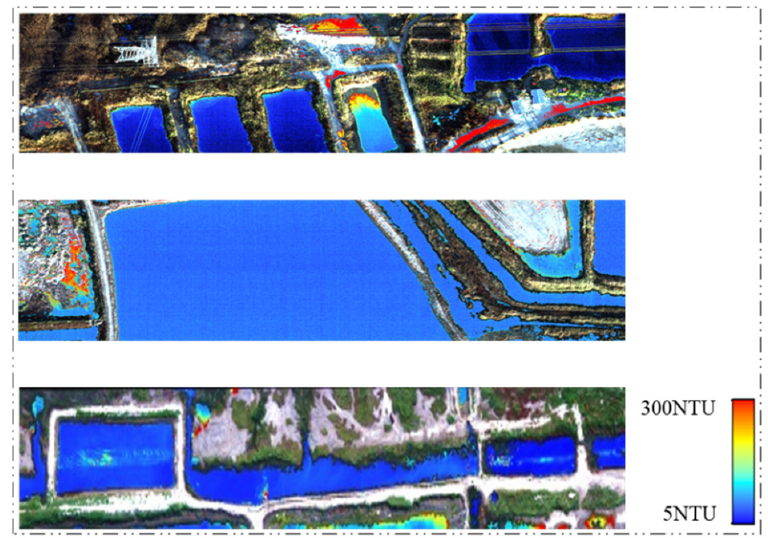
Figure 9. Local turbidity retrieval map of UAV images in PLS model.